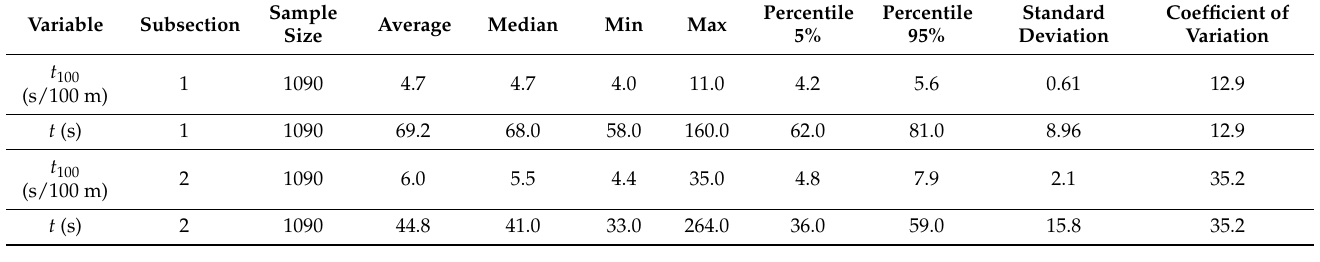
Table 4. Statistical parameters describing travel time variability determined for subsequent 15 min. time intervals.